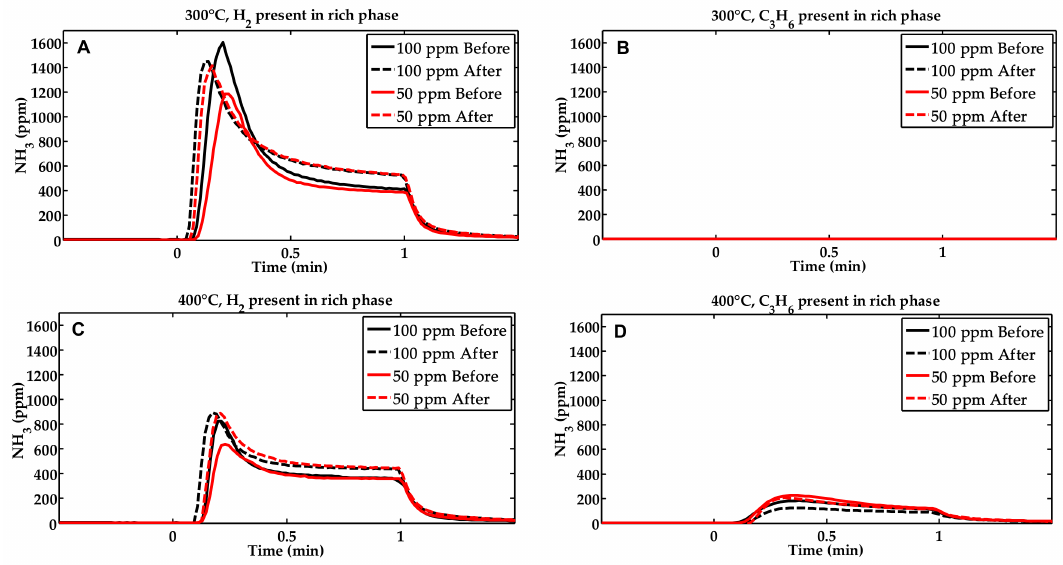
Figure 4. Measured outlet NH 3 concentration before and after exposing Pt/Ba/Al 2 O 3 to 50 or 100 vol.-ppm H 3 PO 4 , 8 vol.-% O 2 and 5 vol.-% H 2 O for 34 h. The rich phase (400 vol.-ppm NO, 5 vol.-% H 2 O, 5 vol.-% CO 2 and H 2 or C 3 H 6 ) starts at time = 0. The lean phase consist of 400 vol.-ppm NO, 5 vol.-% H 2 O, 5 vol.-% CO 2 and 8 vol.-% O 2 , where ( A ) 300 ◦ C with 1 vol.-% H 2 in the rich phase, ( B ) 300 ◦ C with 0.1 vol.-% C 3 H 6 in the rich phase, ( C ) 400 ◦ C with 1 vol.-% H 2 in the rich